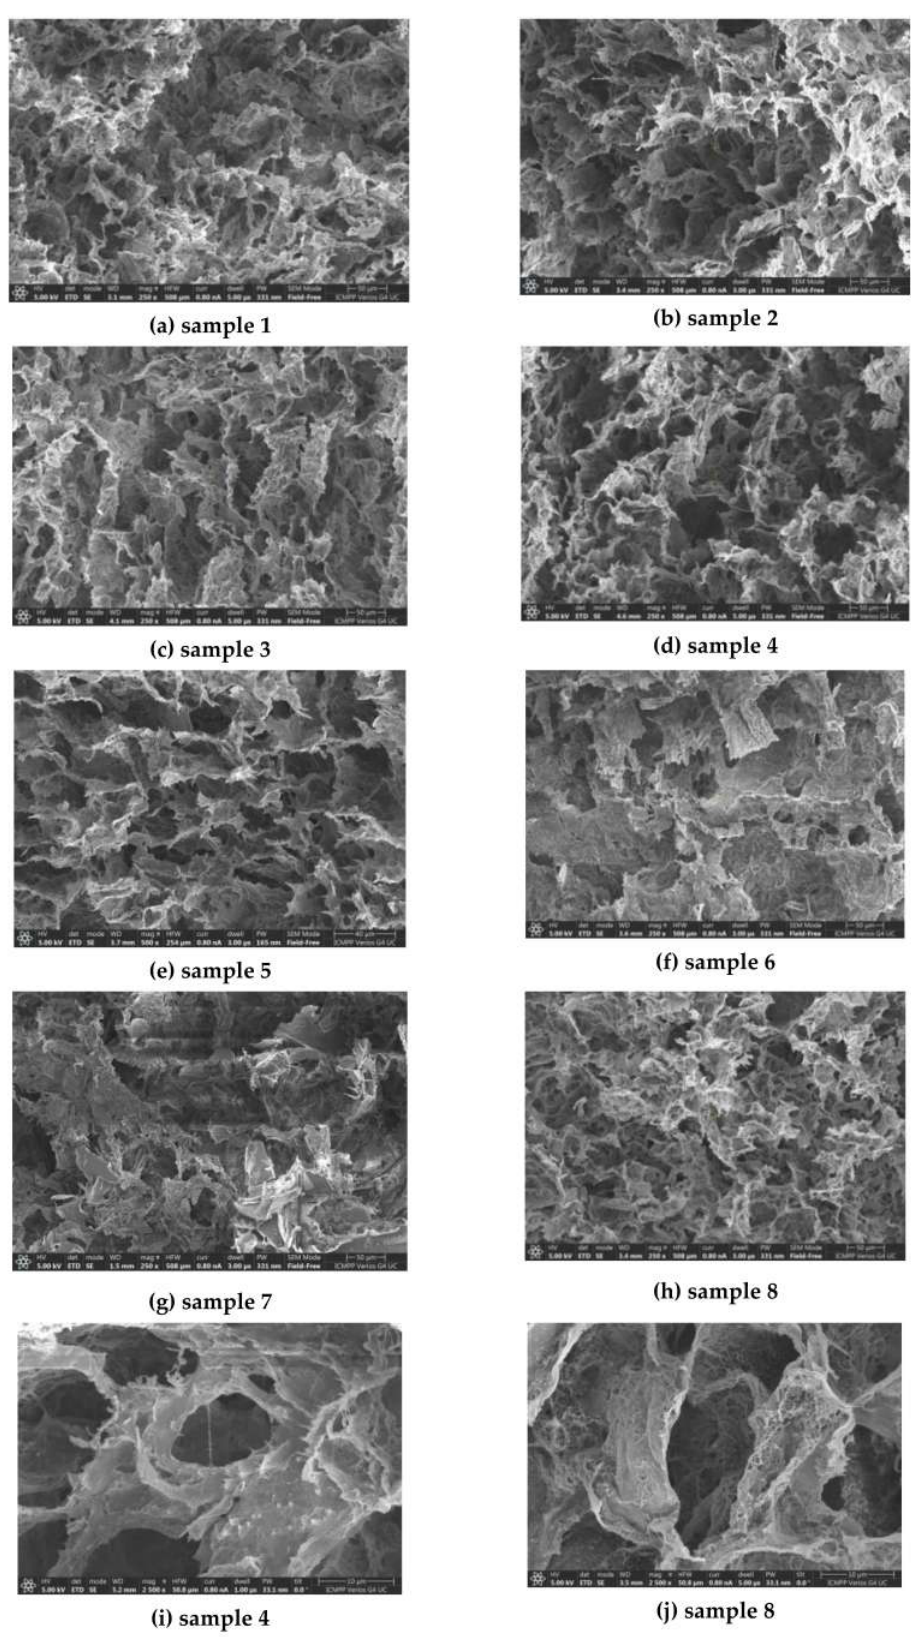
Figure 1. SEM micrographs of dry hydrogels considered in this investigation (Table 1): ( a ) sample 1; ( b ) sample 2; ( c ) sample 3; ( d ) sample 4; ( e ) sample 5; ( f ) sample 6; ( g ) sample 7; ( h ) sample 8. ( i , j ): images at higher magnification ( × 2500) for samples 4 and 8,